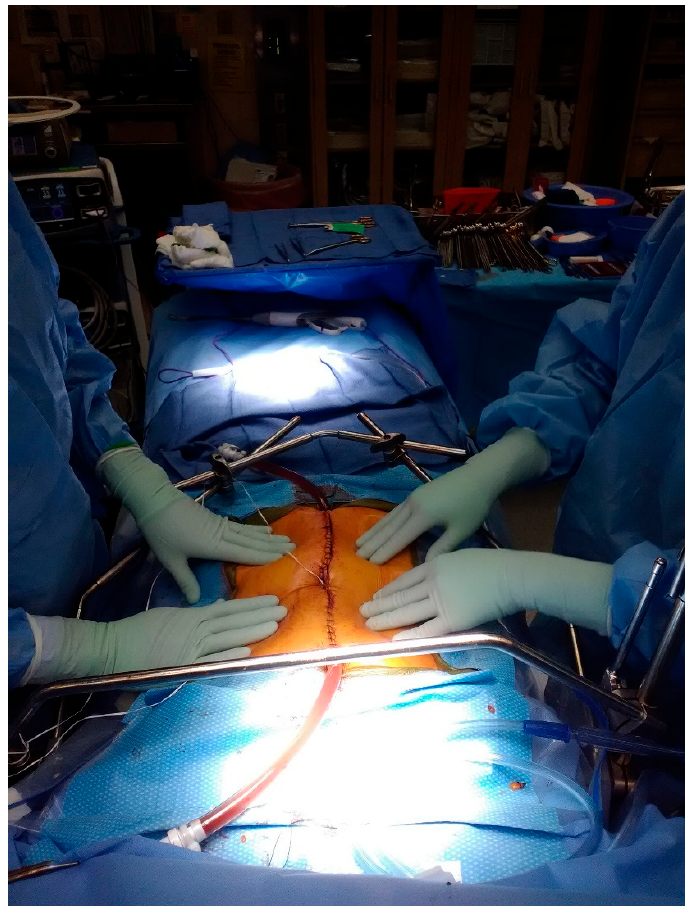
Figure 1. Closed-system hyperthermic intraperitoneal chemotherapy (HIPEC) technique.